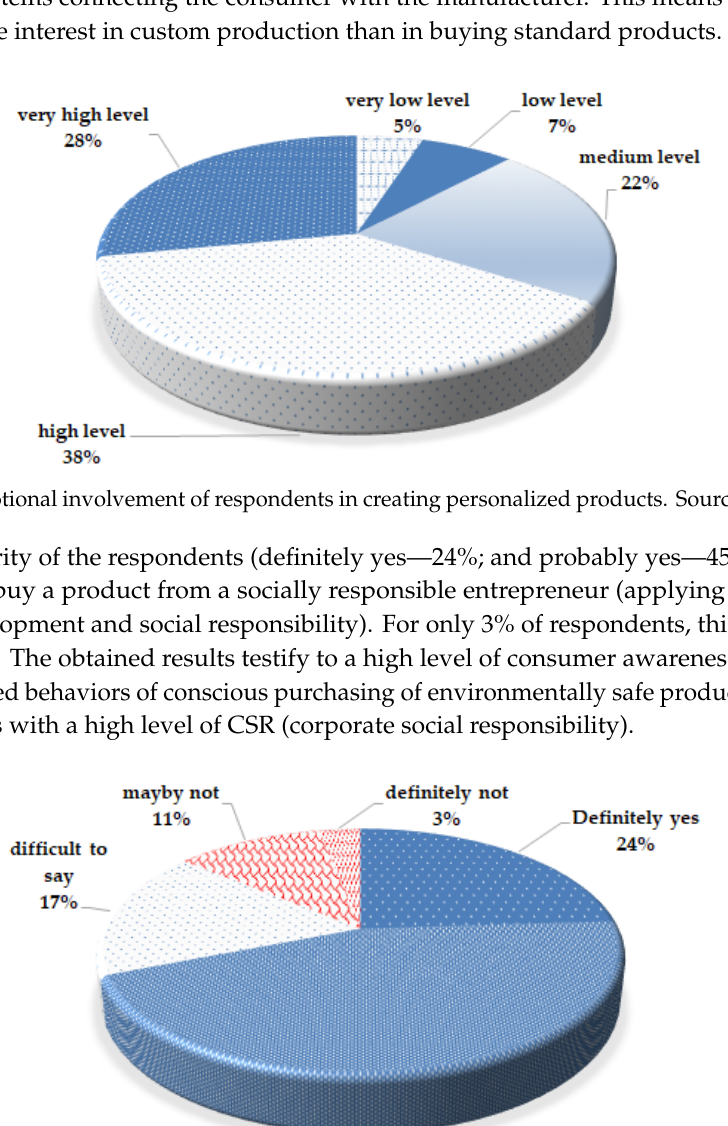
Figure 7. Subjective evaluation of the uniqueness of personalized products. Source: own study.